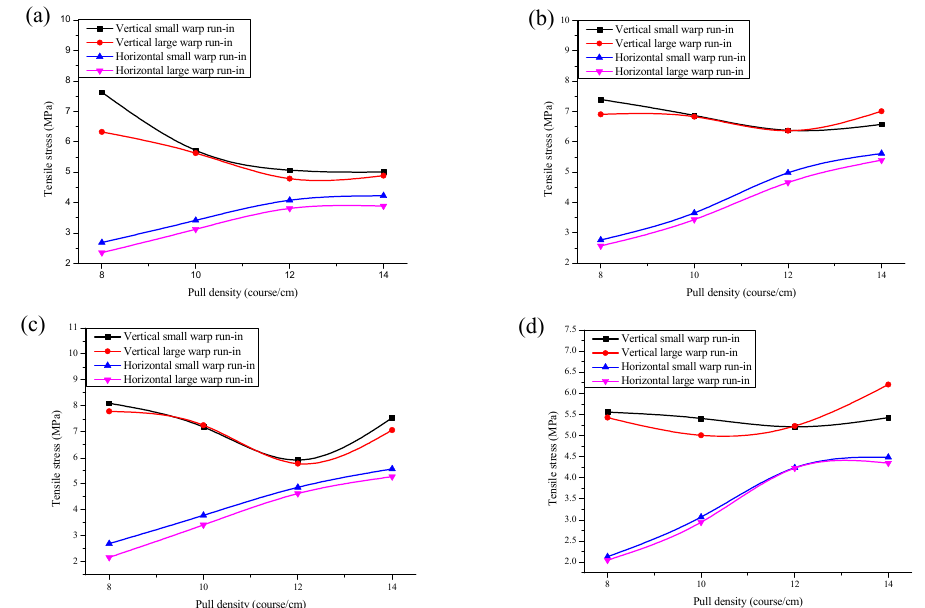
Figure 4. The relationship between the pull density and the vertical and horizontal tensile stress: ( a ) fabric 1#; ( b ) fabric 2#; ( c ) fabric 3# and ( d ) fabric 4#.